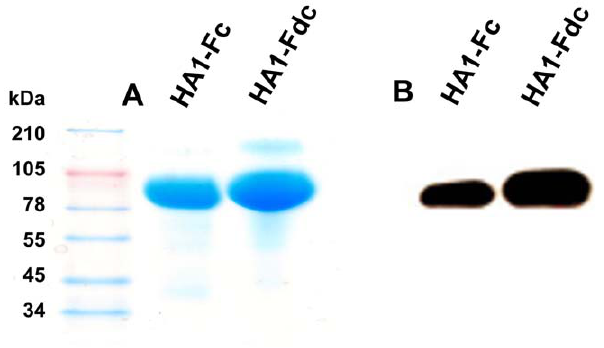
Figure 2. Analysis of the expression of HA1-Fc and HA1-Fdc proteins. The expression of HA1-Fc and HA1-Fdc proteins were performed by SDS-PAGE and Coomassie blue staining (A), and Western blot (B) using a HA-specific mAb. The protein molecular weight marker (kDa) is indicated on the left.